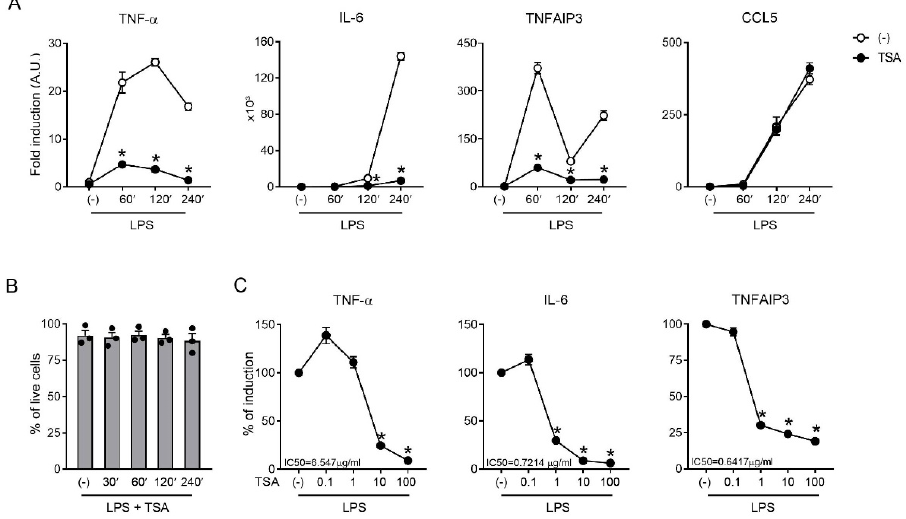
Figure 1. TSA blocked the inflammatory induction of the TNF- α /TNFAIP3 axis. RAW246.7 cells were pre-treated or not for 30 min with 100 ng/mL TSA ( A , B ) or as indicated ( C ) and then stimulated with 1 µ g/mL LPS or left untreated (-) prior to mRNA extraction. ( A – C ) The regulation of different inflammatory mediators was investigated at the mRNA level using RT-PCR. Data are normalized to the housekeeping RNA (18S) and expressed as the mean ± SEM ( n = 3) of 2 − ∆∆ Ct relative to (-). * p < 0.05 versus respective LPS stimulation using an unpaired t -test. ( B ) Cell viability was assessed using a live–dead assay. The results are expressed as the mean ± SEM ( n = 3) of the percentage of live cells. Each dot represents one independent experiment. The lack of statistically significant differences compared with (-) was evaluated using one-way ANOVA with Dunnett’s post hoc